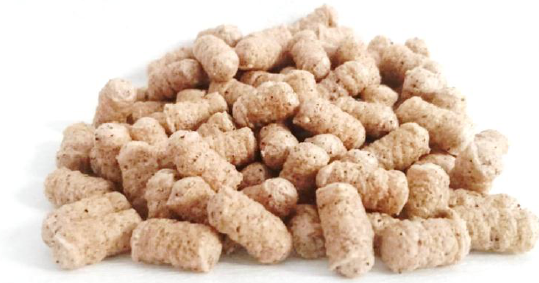
Figure 3. Corn extrudates enriched with cocoa bean shells.